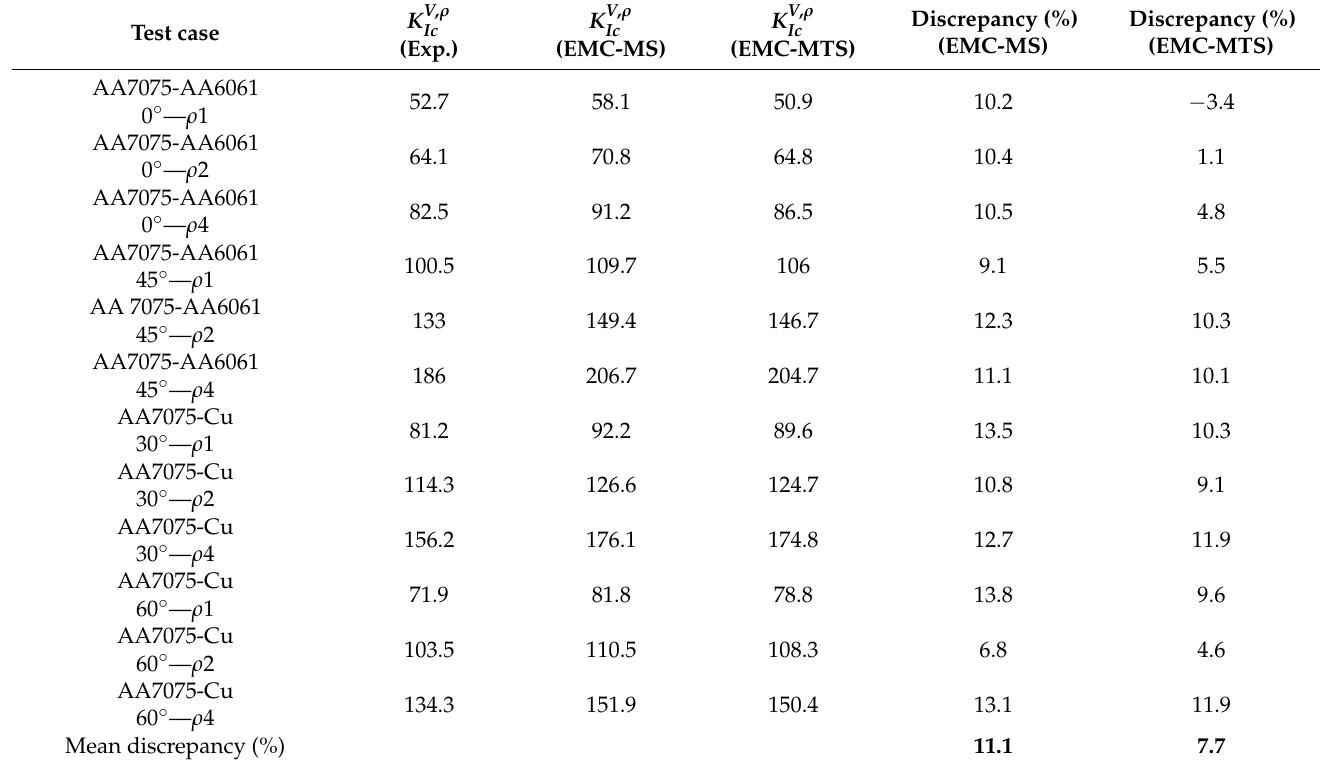
Table 4. Comparison between experimental and theoretical values of the NFT along with the